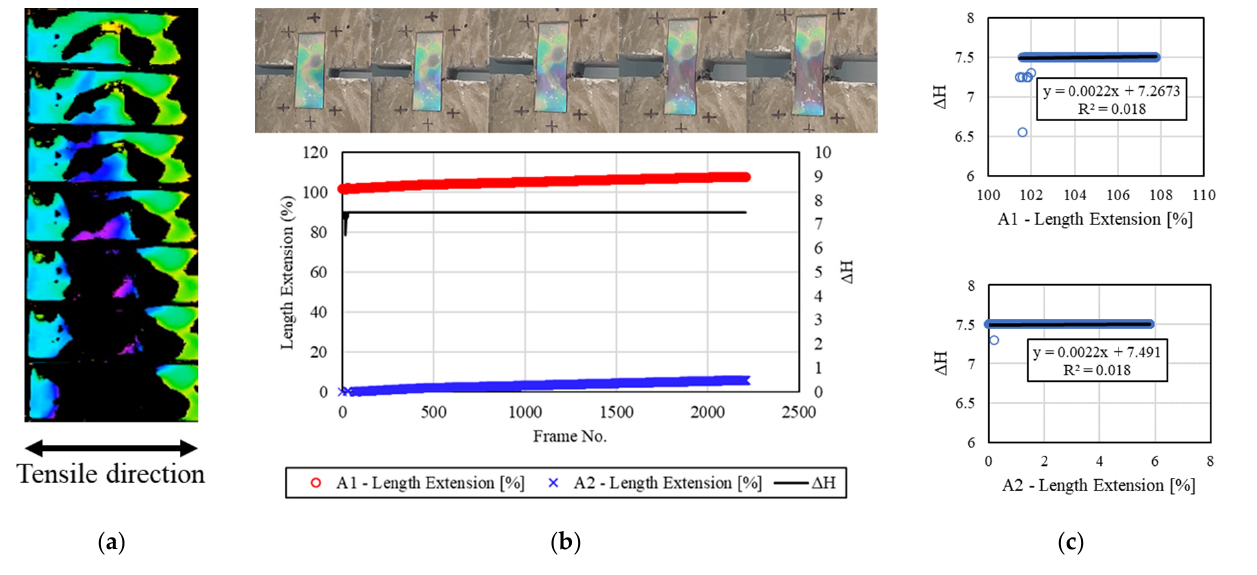
Figure 10. Results for the specimens after 2.5 h. ( a ) H-value image for discoloration color of mechanochromic sensor (90° rotation relative to tensile direction); ( b ) variations in strain and dH of A1 and A2 according to image frame. (The discoloration process of the mechanochromic sensor attached to the specimen and the tensile strain described in Figure 3 are shown.); ( c ) correlations of dH with A1 and A2.